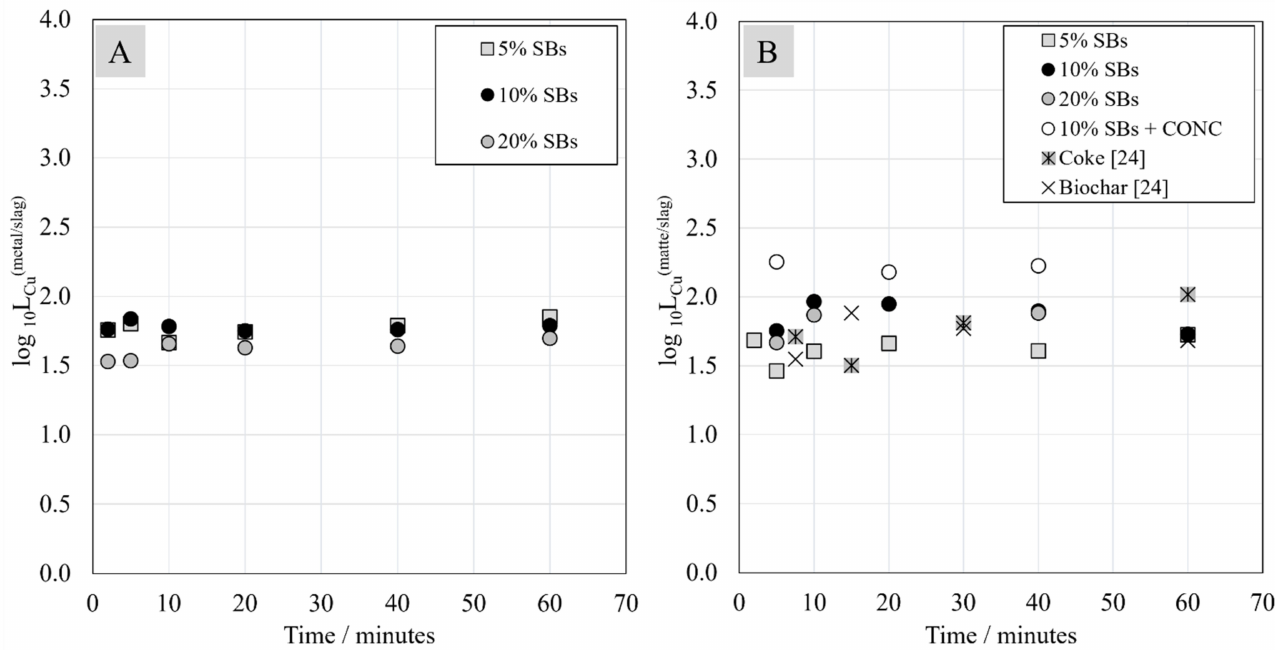
Figure 14. Distribution coefficient of copper between metal alloy and slag ( A ) and between matte and slag ( B ) as a function of contact